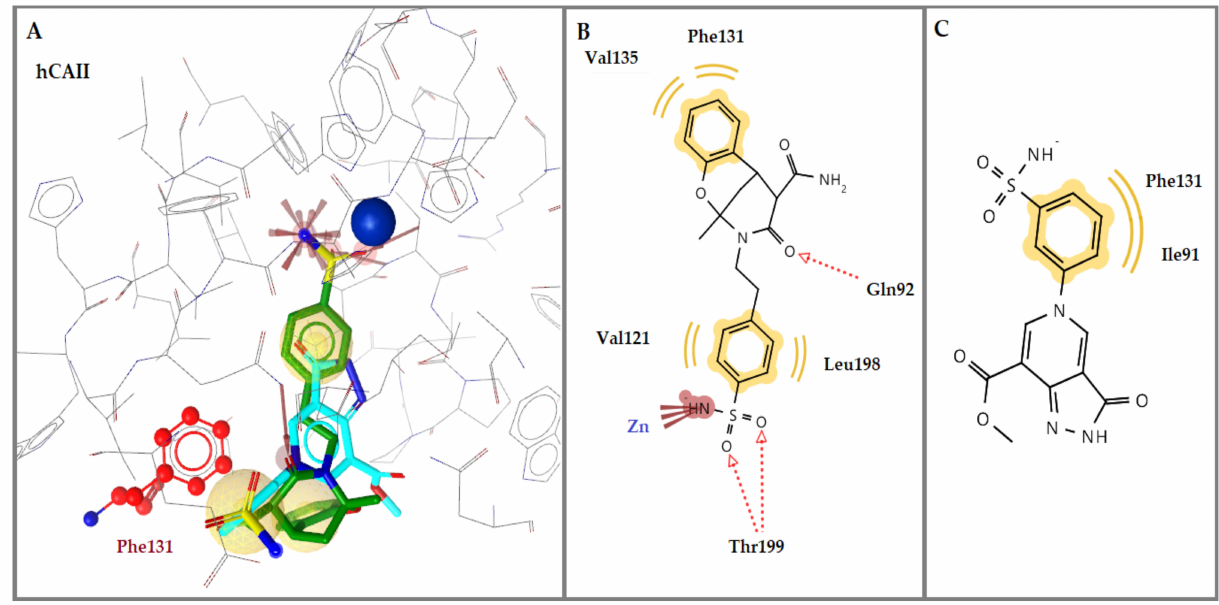
Figure 4. ( A ) Superposition of compound 1k (green) bound to hCA II in comparison with compound 1c (light blue) bound to hCA II, with specific residues labeled. ( B ) 2D interaction diagram of com- pound 1k docking pose interactions with the key amino acids in hCA II. ( C ) 2D interaction diagram of compound 1c docking pose interactions with the key amino acids in hCA II. Active-site zinc shown as blue sphere, red dotted arrows indicate H-bond, and yellow spheres are hydrophobic